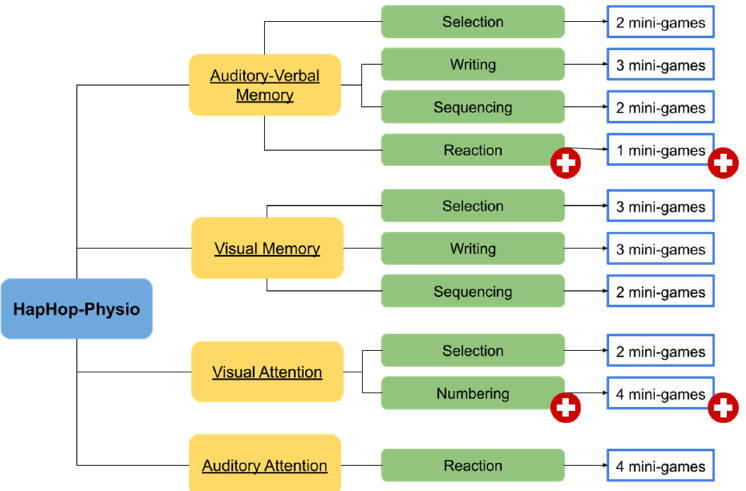
Figure 3. Upgraded structure of HapHop-Physio. Yellow nodes are individual training modules that group mini-game types (green nodes). The plus symbols mark the new types and mini-games.